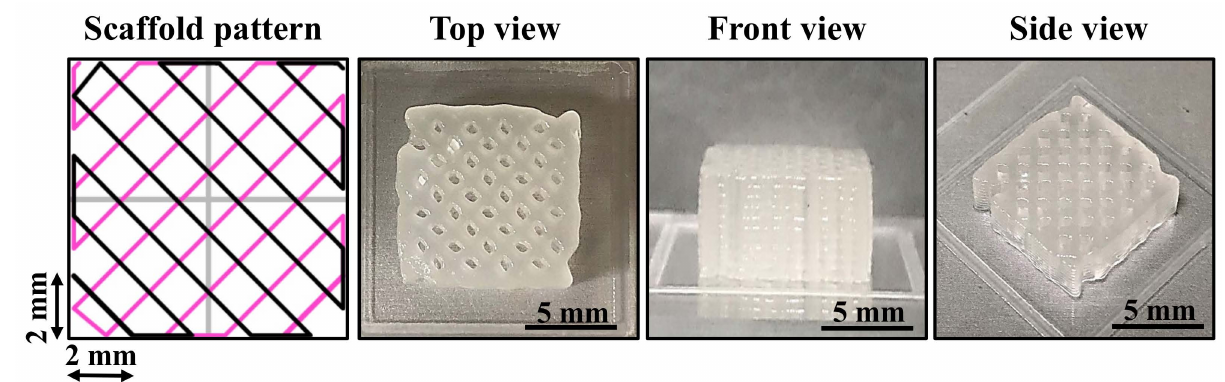
Figure 8. The shape integrity of a cell scaffold (10 mm × 10 mm × 10 mm) from the GBH-2 bioink was maintained for 24 h post-printing. The grid pattern spacing was 2 mm and the print layer was 10